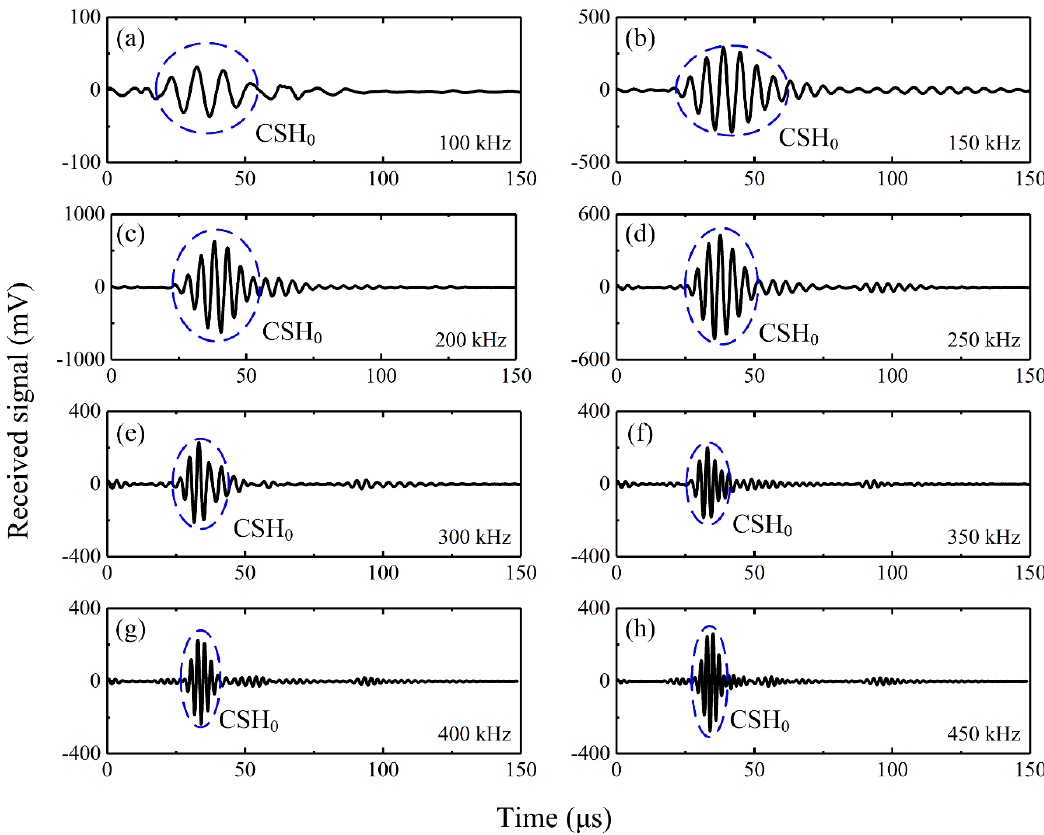
Figure 9. Wave signals excited by the bidirectional piezoelectric transducer at different frequencies and received by another bidirectional piezoelectric sensor in the circumferential direction of the pipe.